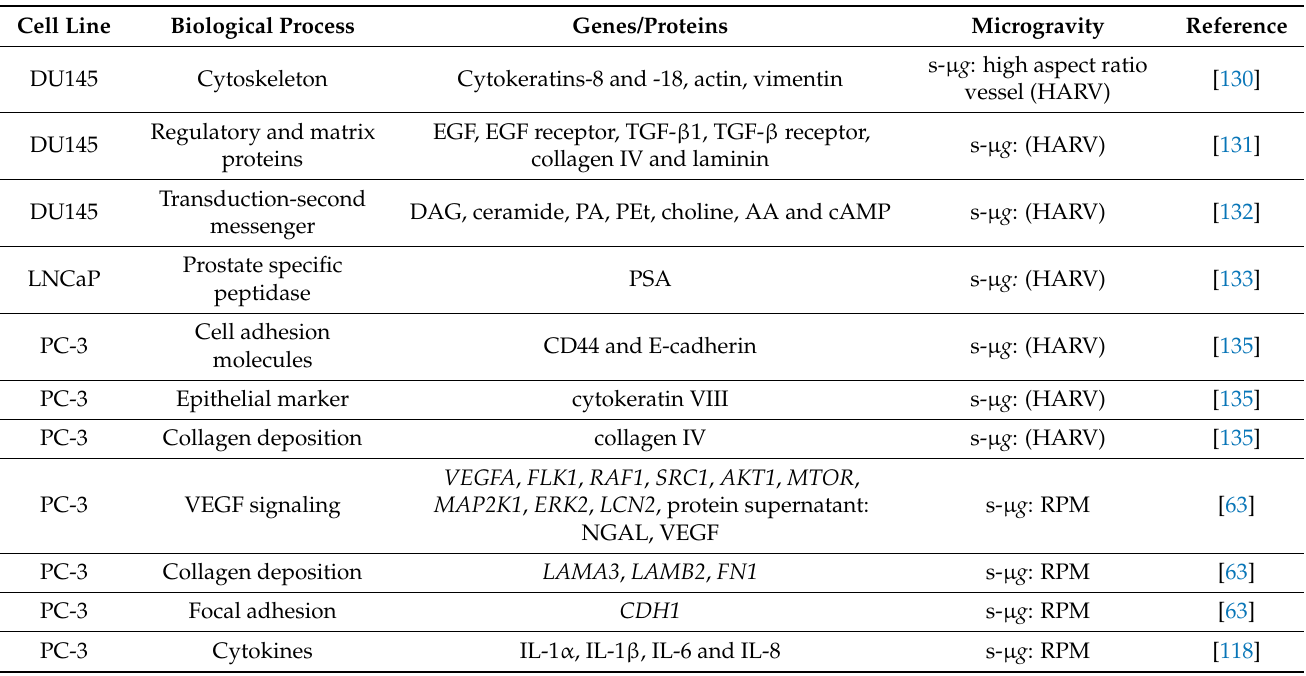
Table 3. Genes and proteins involved in prostate cancer cell spheroid formation under micrograv- ity